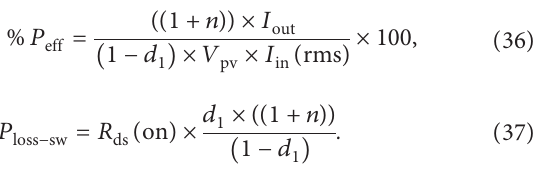
. lm . (d) Gate LS and V GS1 GS4